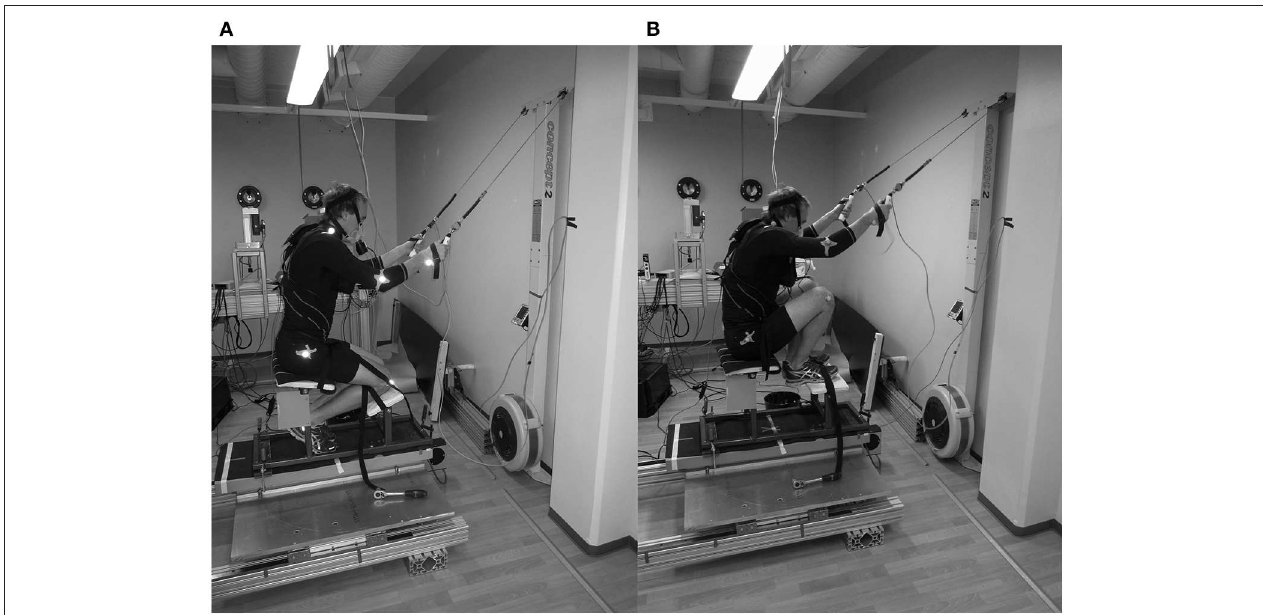
FIGURE 1 | Illustration of the experimental setup during the (A) “kneeing” posture and (B) “knee-high”